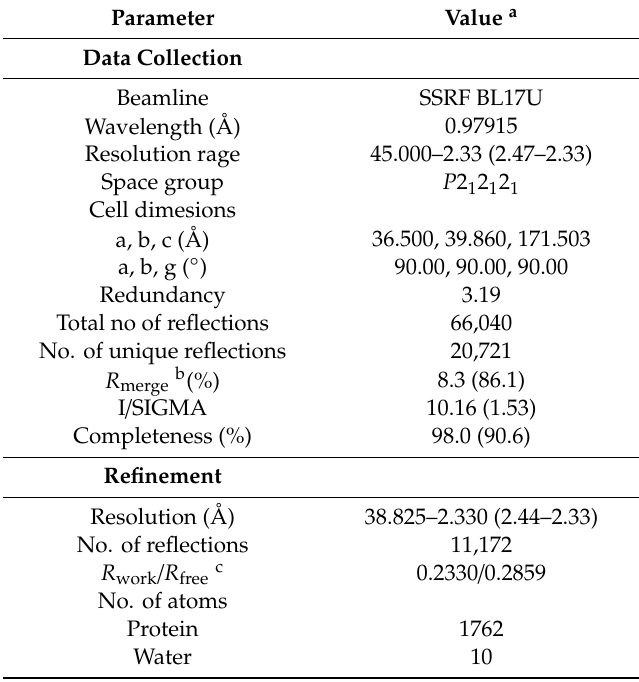
Table 2. Crystallographic data collection and refinement